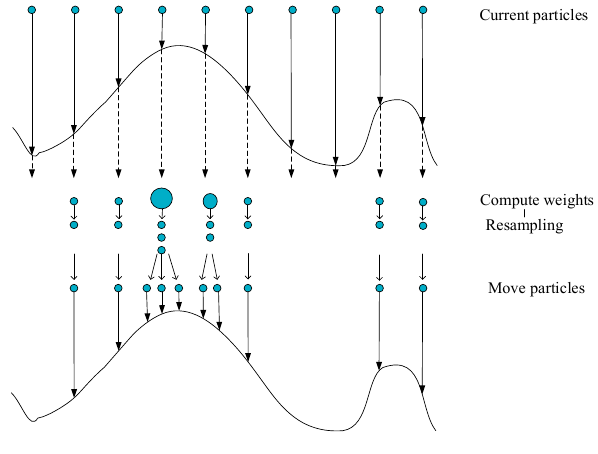
Figure 4. Process of resampling